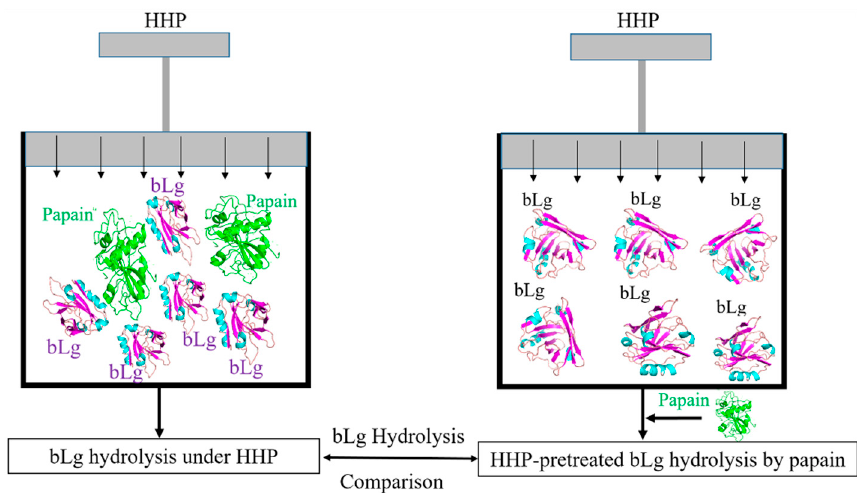
Figure 1. Schematic comparison of b-LG (b-LG) hydrolysis for different pressure treatments.